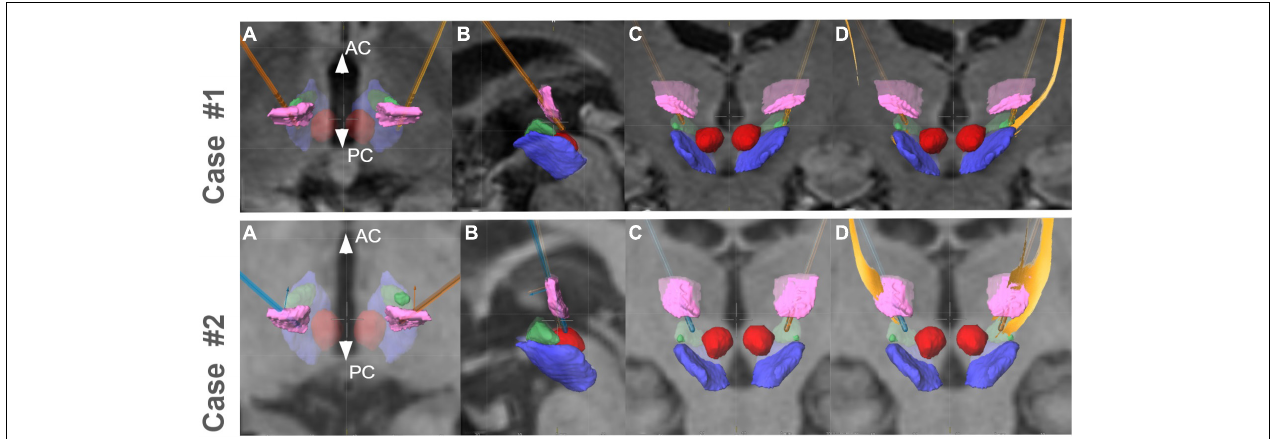
FIGURE A1 | Implantation situation in both cases (upper panel, case 1, lower panel case 2). Ventral intermediate nucleus (Vim, pink) is traversed in both cases. Implantation occurred with the tips of the electrodes somewhat below the ACPC level (typical for Essential Tremor). (A–C) Axial–sagittal–coronal (respectively); (D) coronal with DRT reconstruction (yellow) from planning station (Elements, BrainLab, Munich, Germany). Other objects: red nucleus, red; subthalamic nucleus, green; substantia nigra, blue.